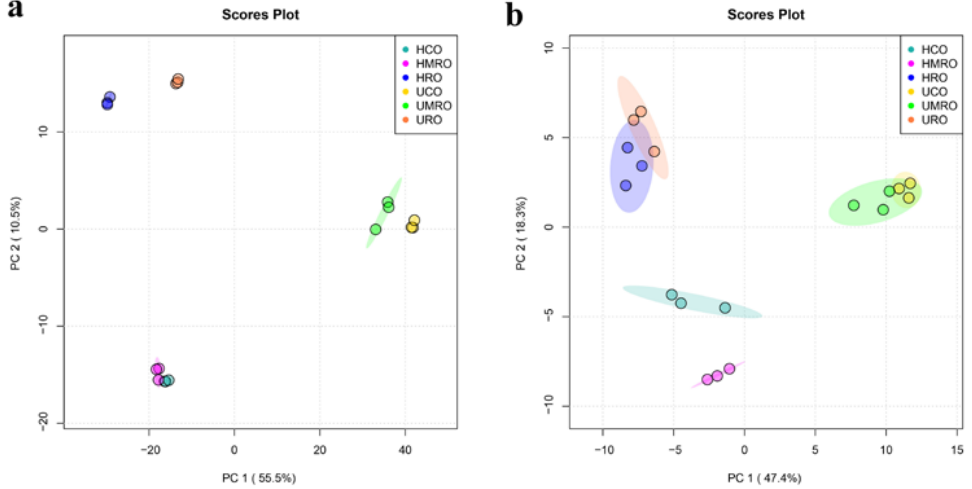
Figure 10. PCA scores plots of camellia oil before and after heating based on non-targeted lip- idomics: ( a ) positive ion mode; ( b ) negative ion mode.